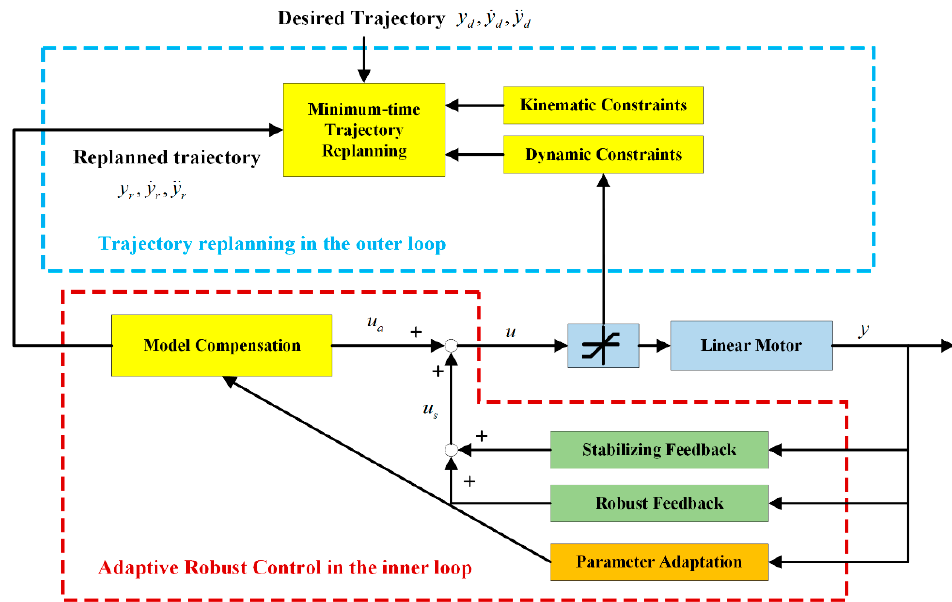
Figure 16. The control structure of the online trajectory re-planning algorithm and adaptive robust controller. Reprinted with permission from ref. [1]. Copyright 2019